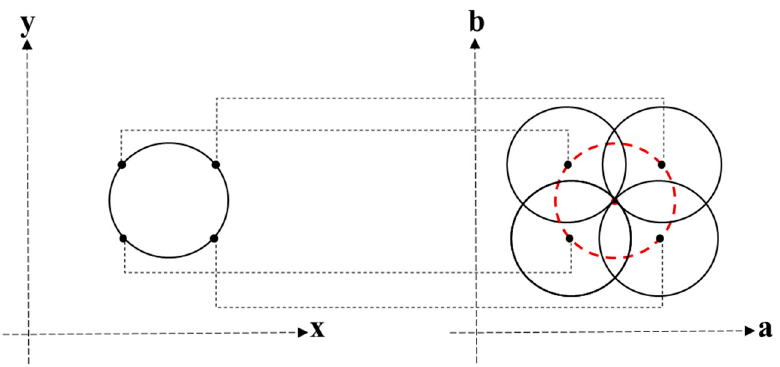
Figure 1. Conversion of the image space into the Hough